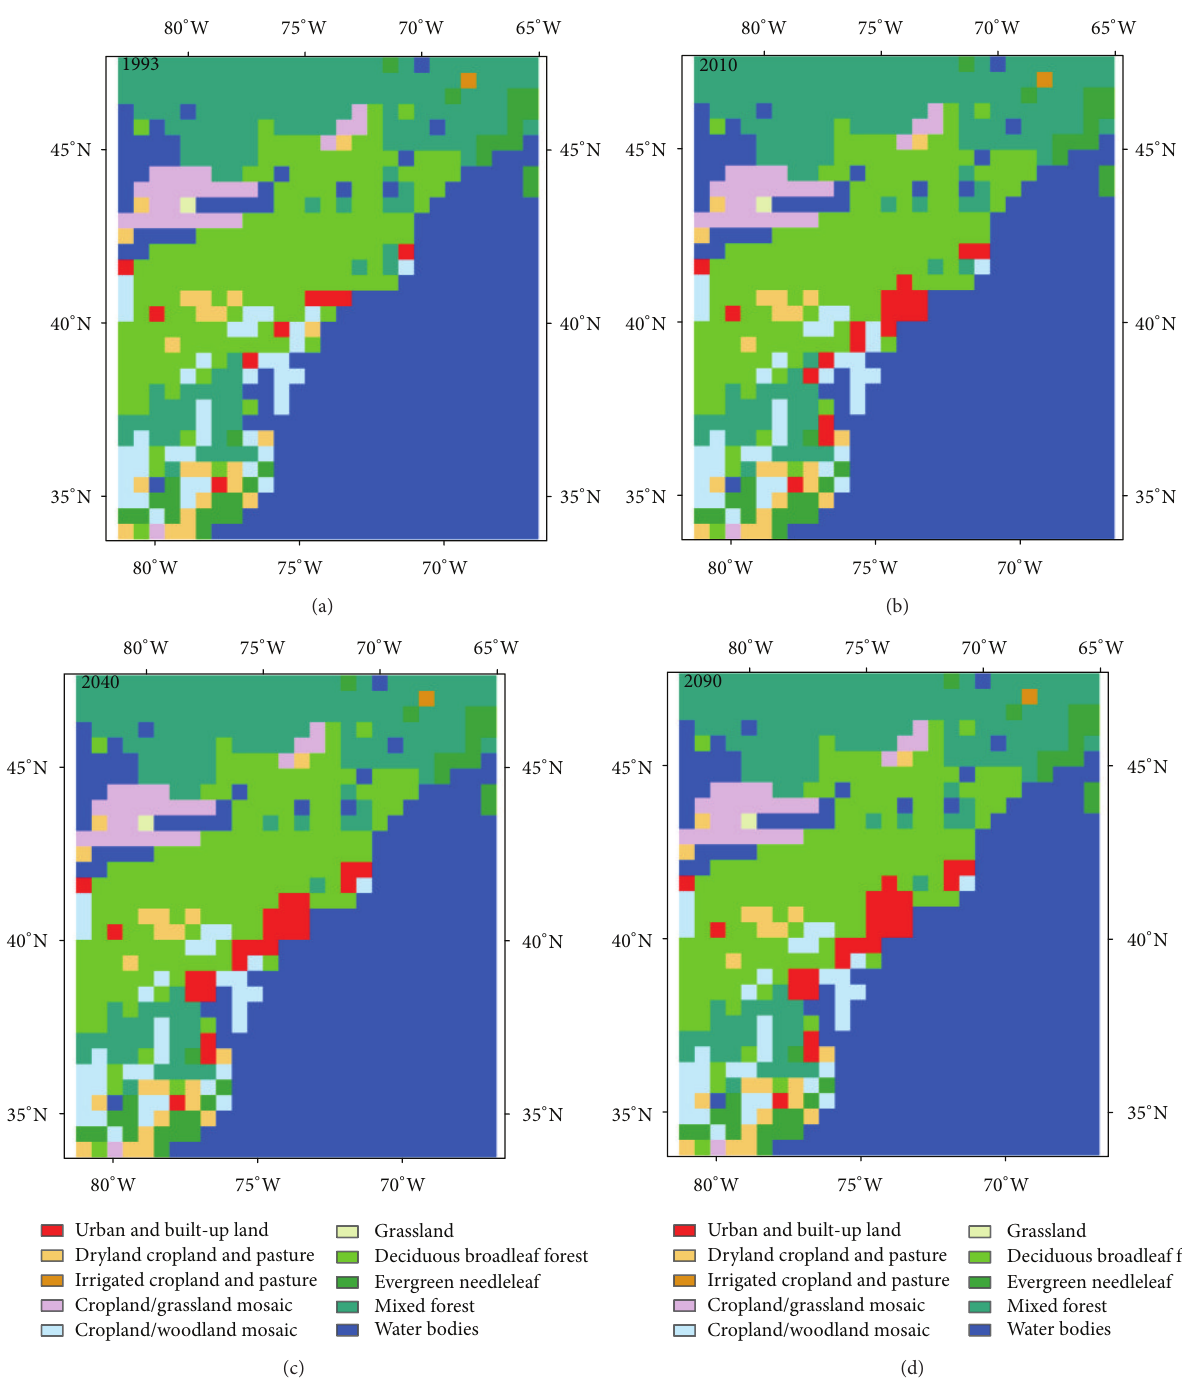
Figure 2: Baseline underlying surface data (1993) and predicted underlying surface data (2010, 2040, and 2090) used in this study.